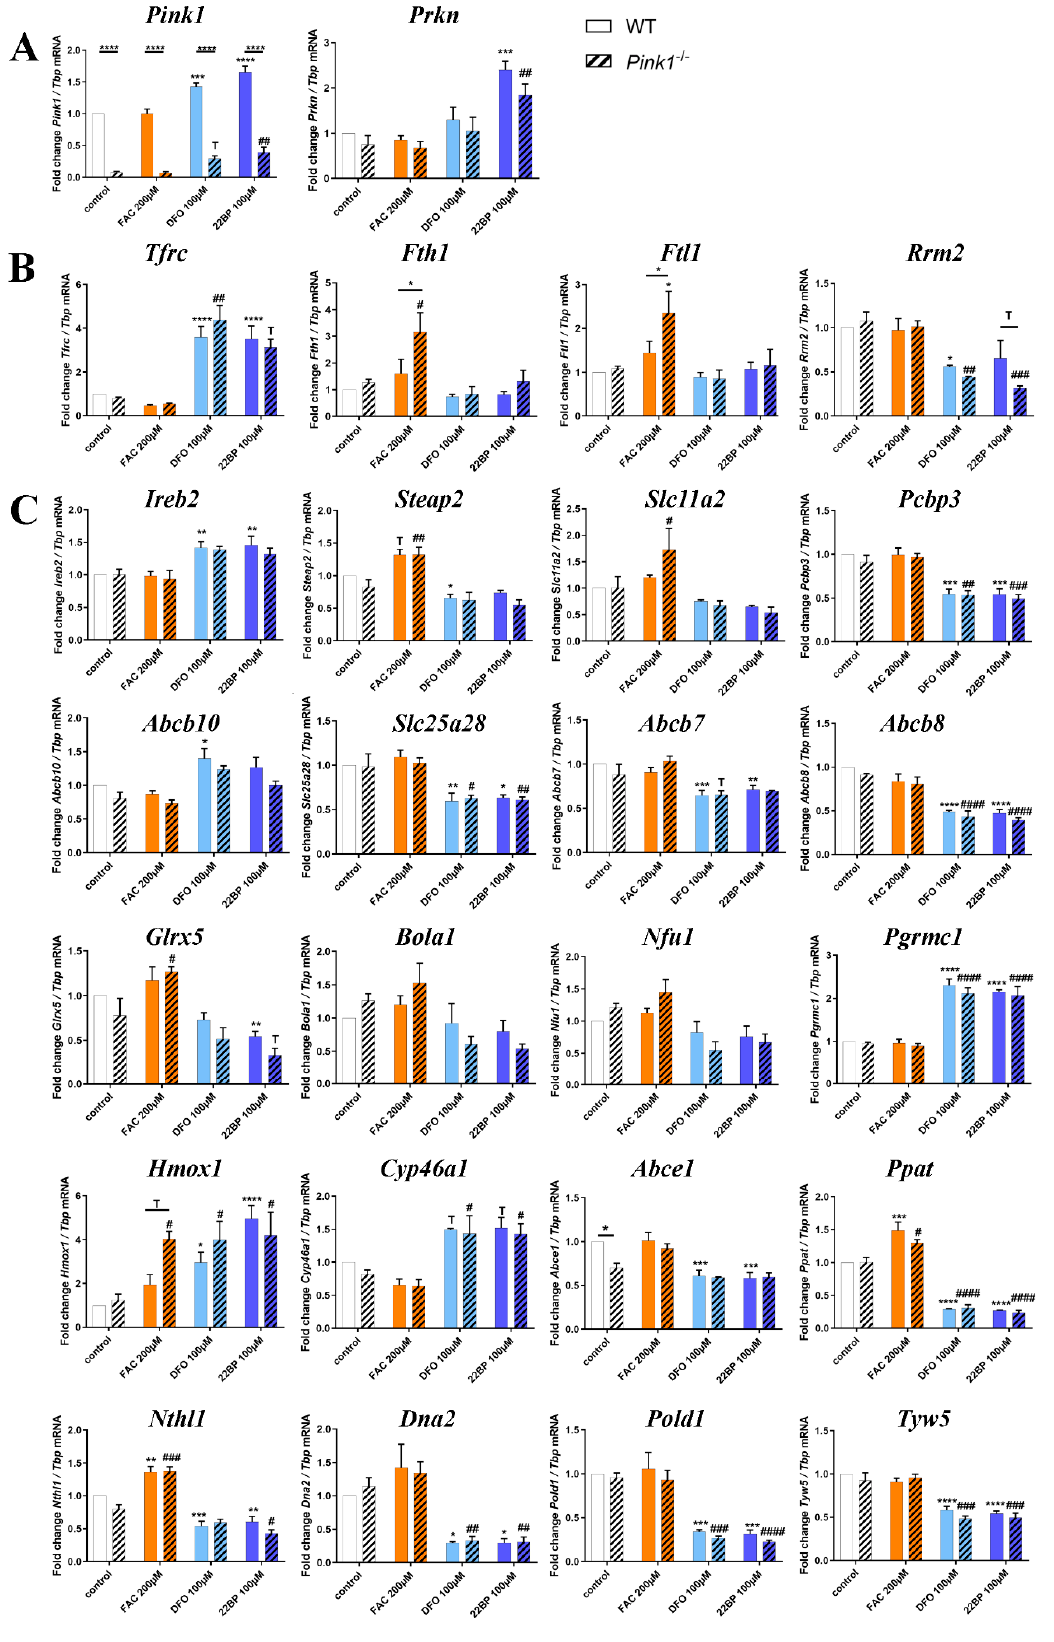
Figure 3. Synopsis of mRNA expression dysregulations upon RT-qPCR in MEF cells ( n = 3 WT for Pink1 and Prkn , else 6–12 WT versus 3 Pink1 − / − for all other factors) after iron manipulation, focusing